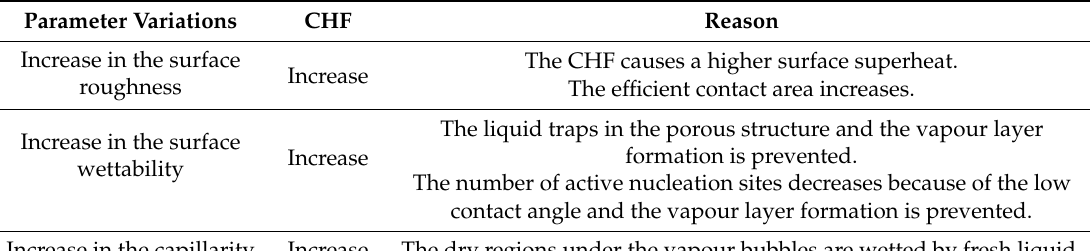
Table 2. Summary of the parameter variation impacts on